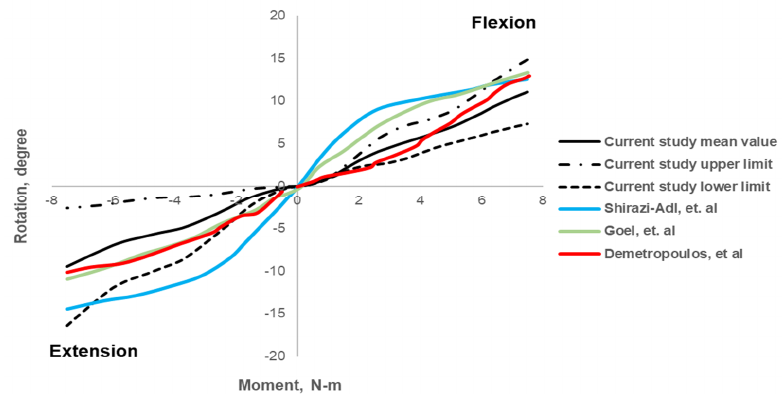
Figure 5. Variation of angle with respect to applied moment on the superior surface of the lumbar model during flexion and extension.